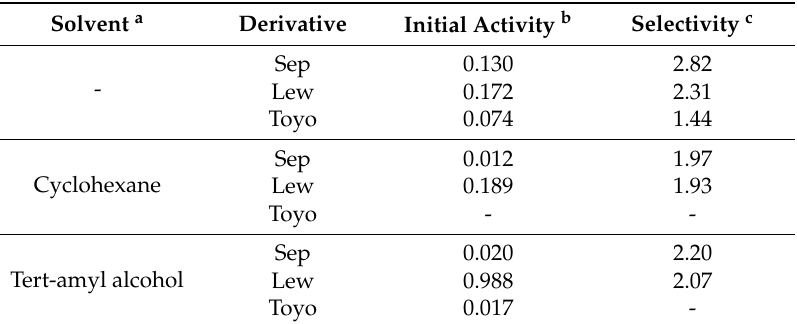
Table 5. Sardine oil ethanolysis by Penicillium sp. (CBMAI 1583) lipase